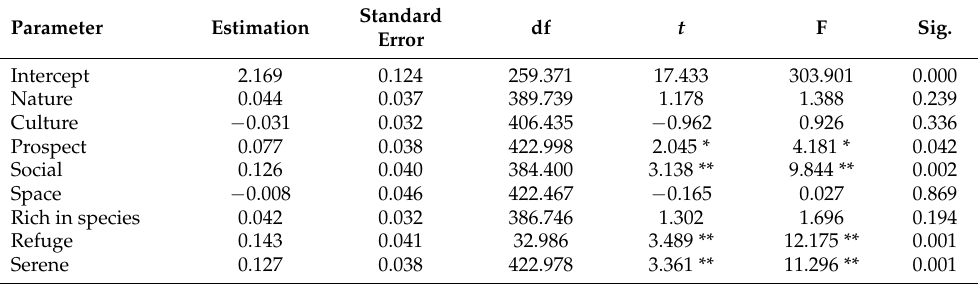
Table 8. Effects of PSDs on stress